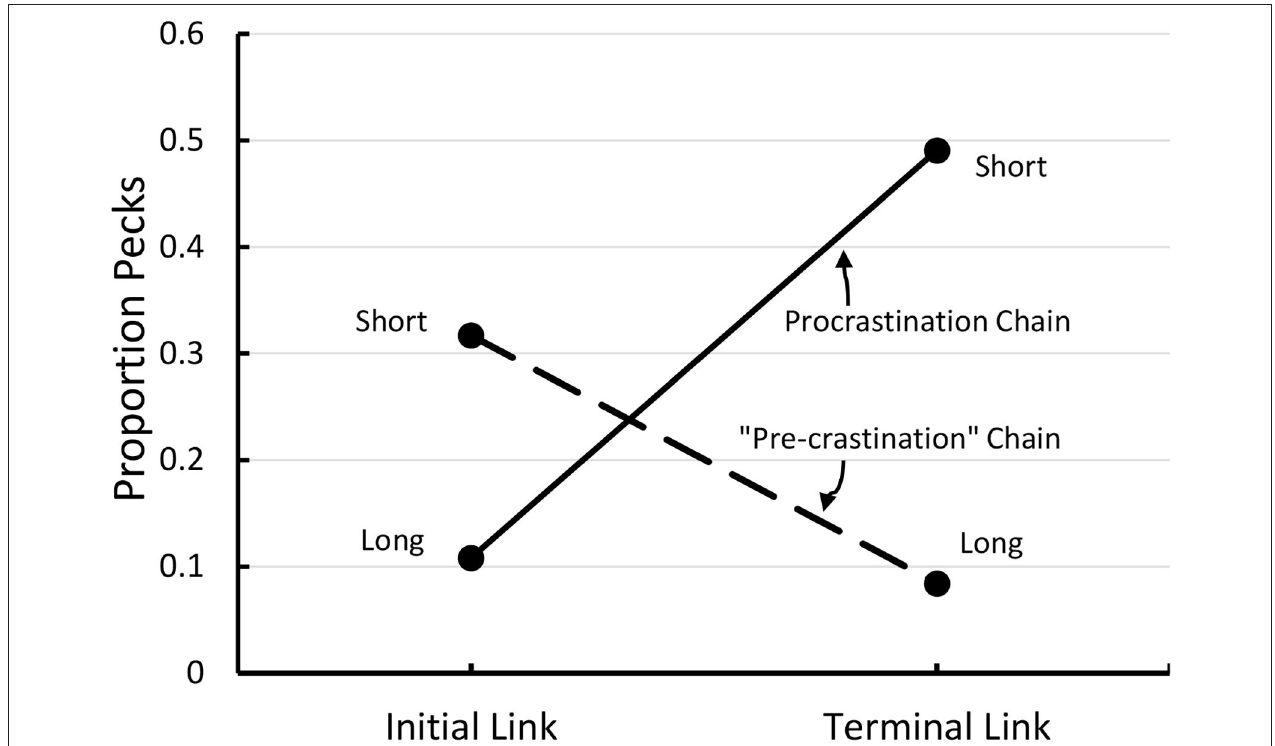
FIGURE 7 | Proportion of pecks to each of the four components of the two chains depicted in Figure 5 . Pigeons preferred the long-short (procrastination) chain over the short-long (“pre-crastination”) chain.